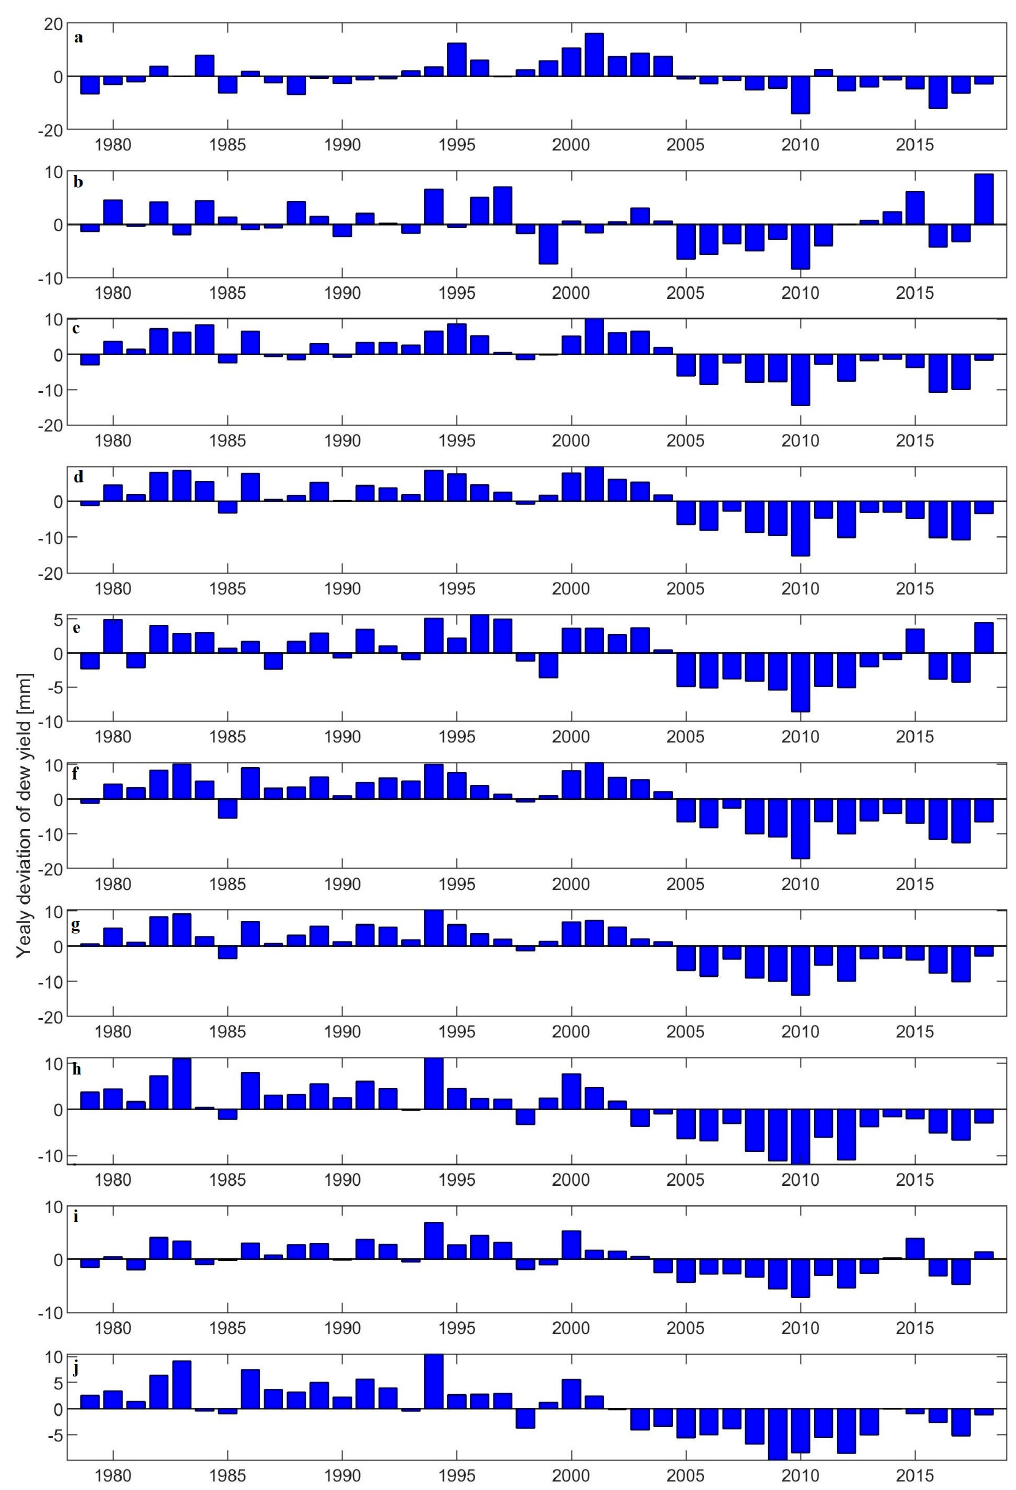
Figure 3. Difference between mean yearly dew yield and yearly long term mean during 1979–2018 at the selected sites: ( a ) Irbid, ( b ) Mafraq, ( c ) Amman, ( d ) Madaba, ( e ) Azraq, ( f ) the Dead Sea, ( g ) Karak, ( h ) Petra, ( i ) Ma’an, ( j ) Aqaba. The subplots are in sequential order according to site number from 1 to 10 (Figure 1).